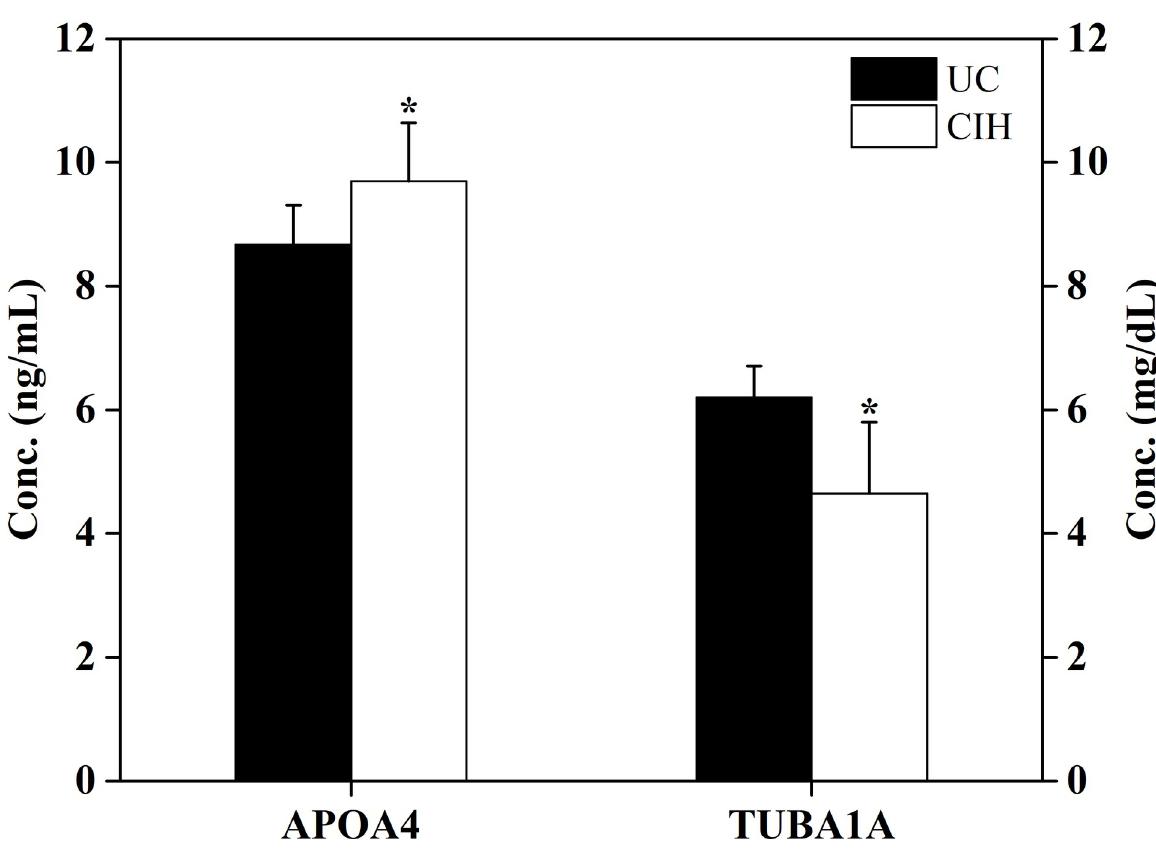
Fig 3. Comparison of serum APOA4 and TUBA1A levels in control and CIH groups. � p < 0.05 compared with control group.